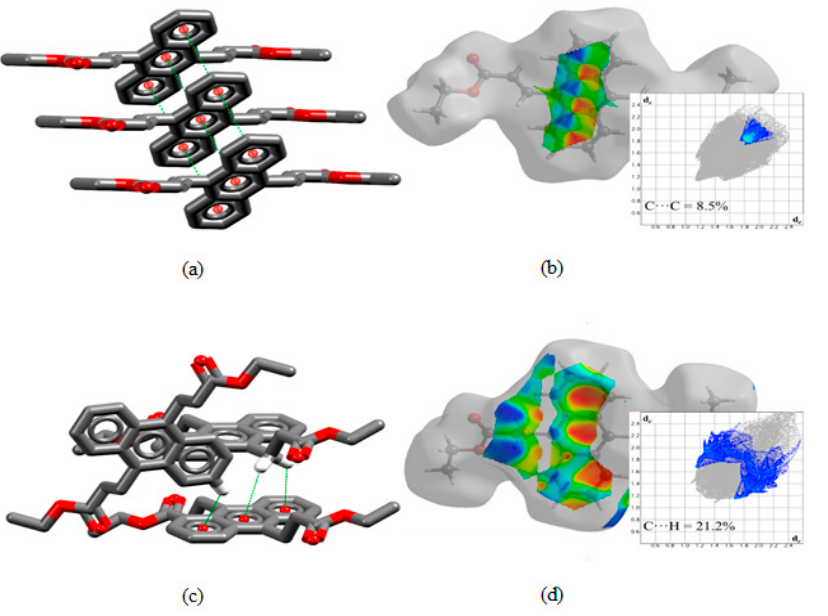
Figure 8. Representation of π · · · π interactions ( a ) and the shape index surface followed by 2D fingerprint plot ( b ) confirming the stacking of DADB; C–H · · · π interactions ( c ) and the shape index surface followed by 2D fingerprint plot ( d ) confirming the arrangement of DEADP.